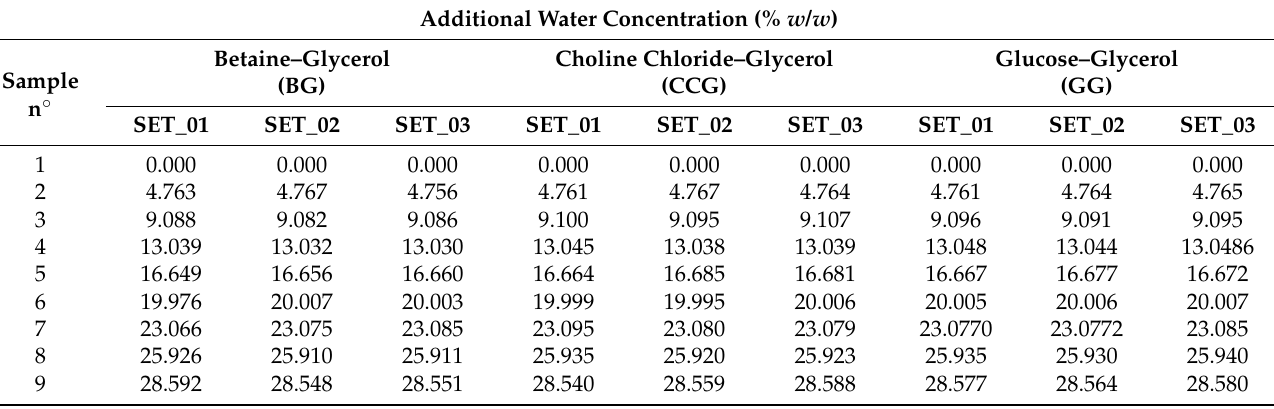
Table 1. List of samples prepared for the 3 NADES